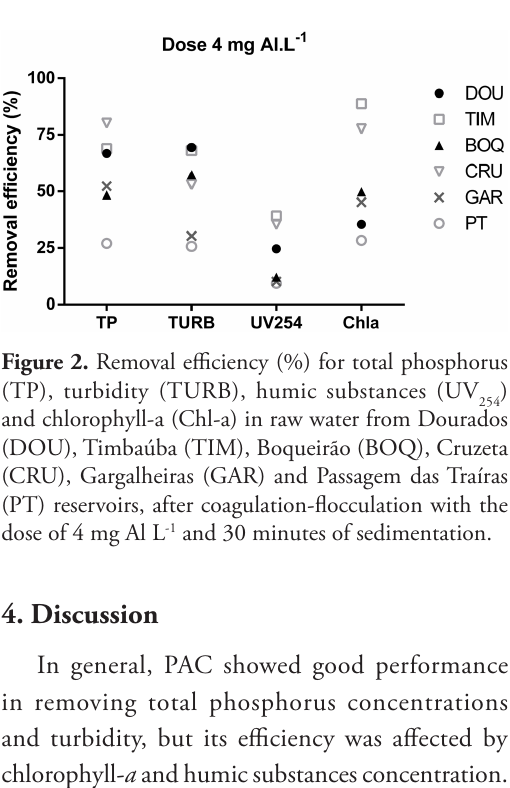
Figure 1. Removal efficiency (%) for total phosphorus (TP), turbidity, humic substances (UV (Chl-a) in raw water from Dourados (DOU), Timbaúba (TIM), Boqueirão (BOQ), Cruzeta (CRU), Gargalheiras (GAR) and Passagem das Traíras (PT) reservoirs, after coagulation-flocculation with different concentrations of aluminium (0, 2, 4, 6, 8 and 10 mg Al L -1 ) and 30 minutes of sedimentation.